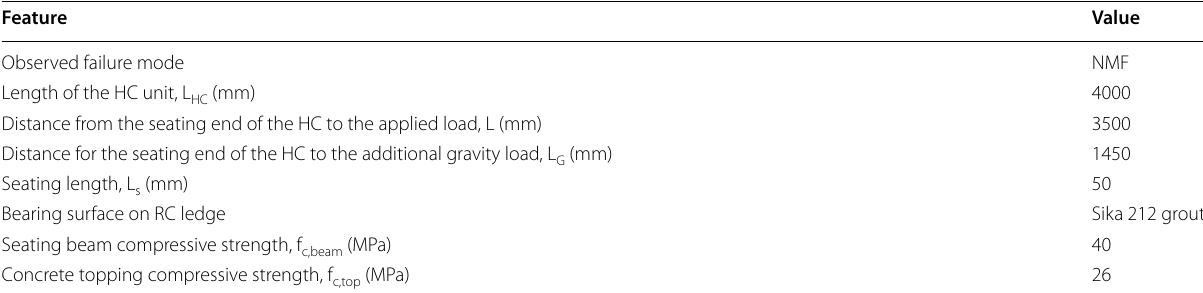
Table 1 Summary of key features of the sub-system test used for the calibration of the FE model